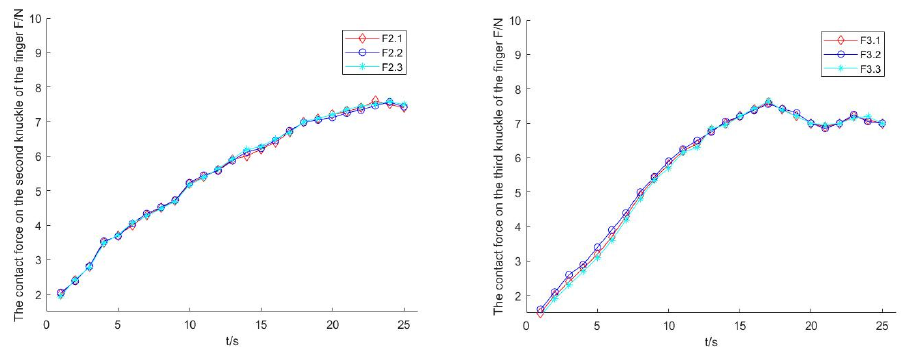
Figure 20. Contact force of the second and third knuckles when grasping the ball.